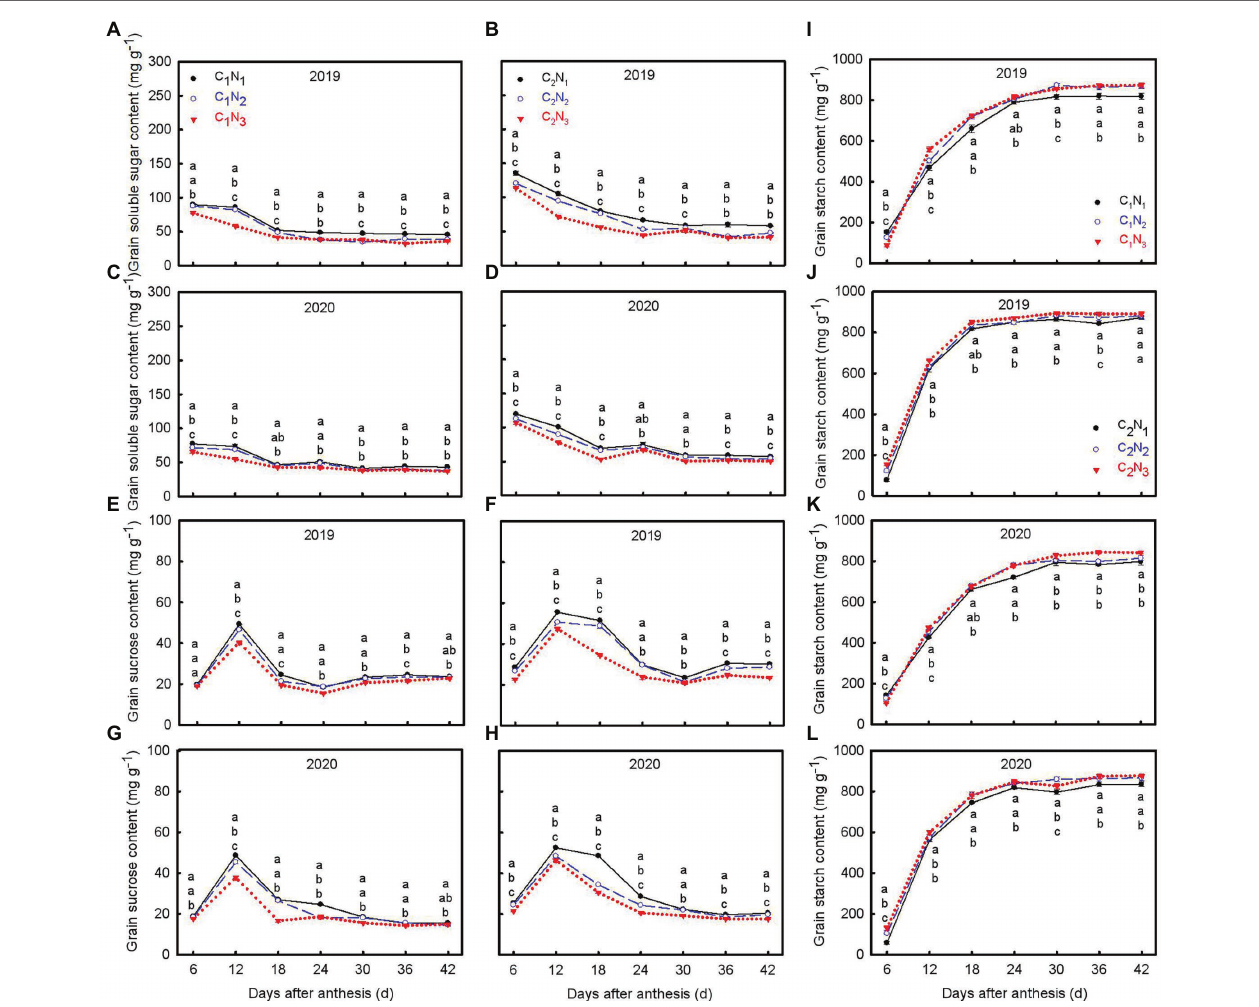
FIGURE 4 | Changes of soluble sugar (A–D) , sucrose (E–H) , and starch (I–L) contents in grains at 6, 12, 18, 24, 30, 36, and 42 days after anthesis under different N application rates. Data are mean ± SE ( n = 3). Different lowercase letters from top to bottom indicate statistical difference between treatments at the 0.05